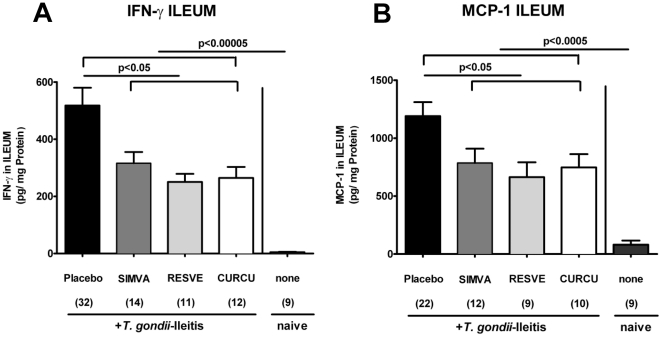
(A) IFN-γ and (B) MCP-1 concentrations (CBA-ELISA) in supernatants of ileum cultures from naïve, uninfected animals and mice treated with Simvastatin (SIMVA), Resveratrol (RESVE) or Curcumin (CURCU) from d-2 until d8 p.i. as compared to Placebo controls (8 days after T. gondii infection).Numbers of analyzed animals are given in parentheses. Mean values, standard errors of the mean, and significance levels as indicated were determined by the Student's t test. Data are pooled from at least two independent experiments.